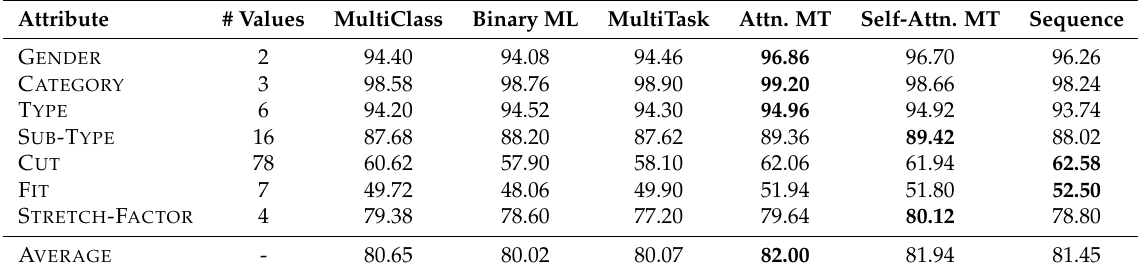
Table 3. Attribute level accuracies on the Rakuten test set for all models. Binary ML stands for Binary MultiLabel model, Attn. MT stands for Attentive MultiTask model, Self-Attn. MT denotes the Self-Attentive MultiTask model.